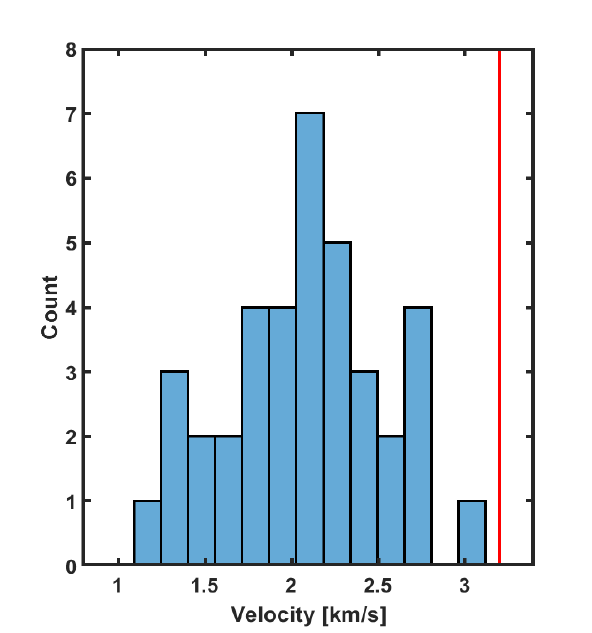
Figure 10. Velocity distribution of the fragments tracked with the presented algorithm. Vertical red line marks the impact velocity.